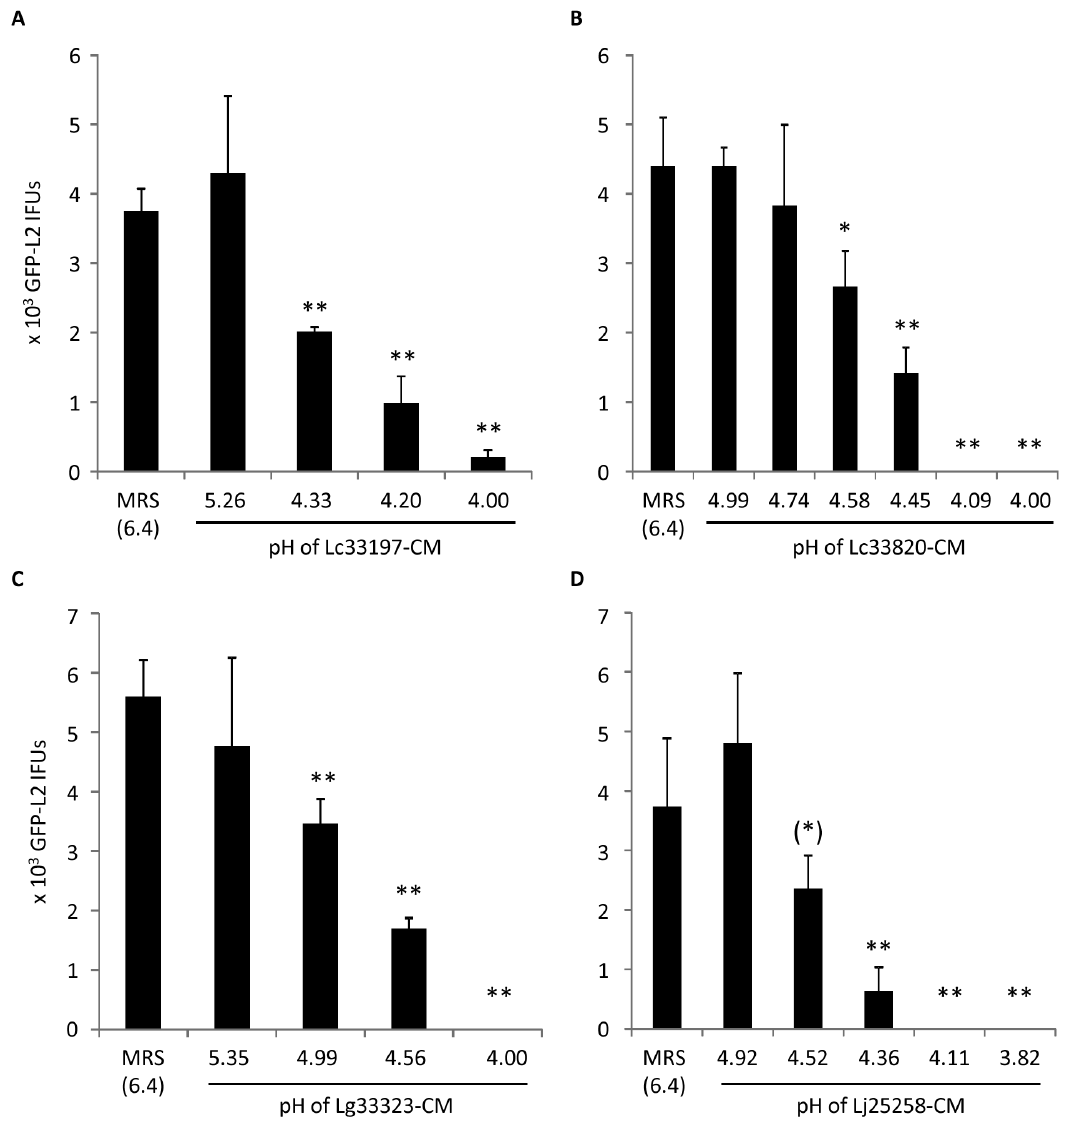
Figure 2. Effects of LCM longitudinally collected from still cultures of Lc33197 (A), Lc33820 (B), Lg33323 (C) and Lj25258 (D). pH values of LCM are shown on the horizontal axis. GFP-L2 EBs were treated for 1 h. Surviving bacteria were quantified as outlined in Fig. 1 legend. Values were averages 6 standard deviations of triplicate experiments. Single and double asterisks above LCM-treated samples denote statistically decreased IFUs (P , 0.05 and P , 0.01, respectively) as compared to control MRS Lactobacillus medium-treated samples. The parenthetic asterisk indicates statistically decreased IFUs in samples treated with LCM (pH 4.52), as compared to IFUs that survived the treatment with LCM (pH 4.92), although the P value between control MRS (pH 6.4) and MRS (pH 4.52) was